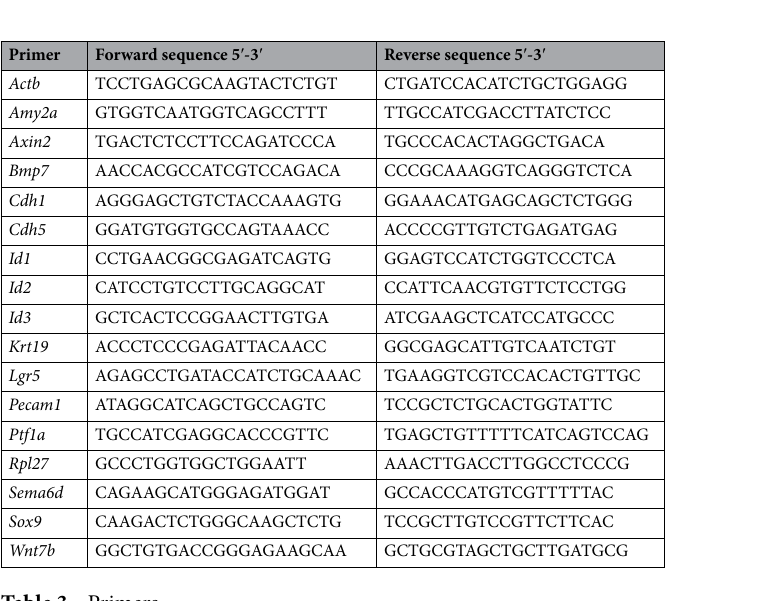
Table 3. Primers.